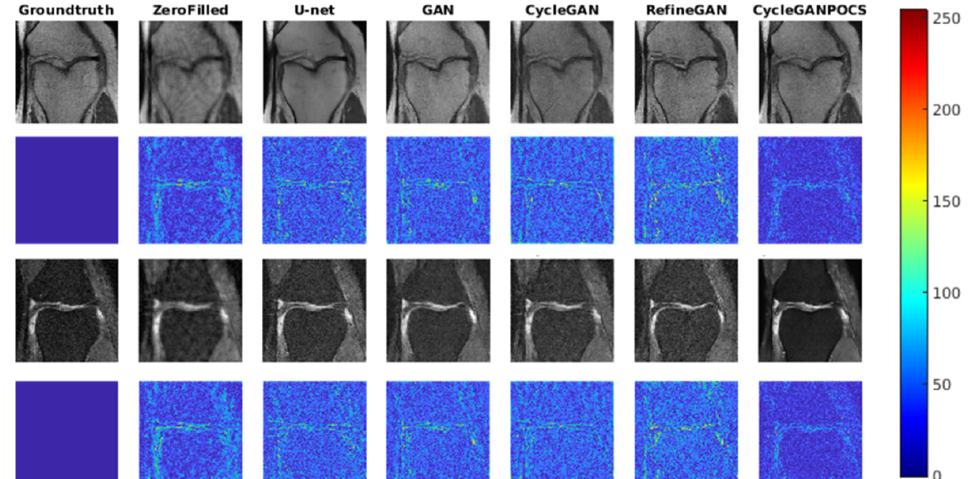
Figure 7. The fully sampled and undersampled knee images. The first and third rows are the knee images, and the second and fourth rows are the differences between the reconstructed image and the ground truth. The methods used for reconstructing the images are provided on top of each column. The undersampling rate was 10%, with a pseudo-random radial sampling trajectory. The color bar is set between [0, 255].